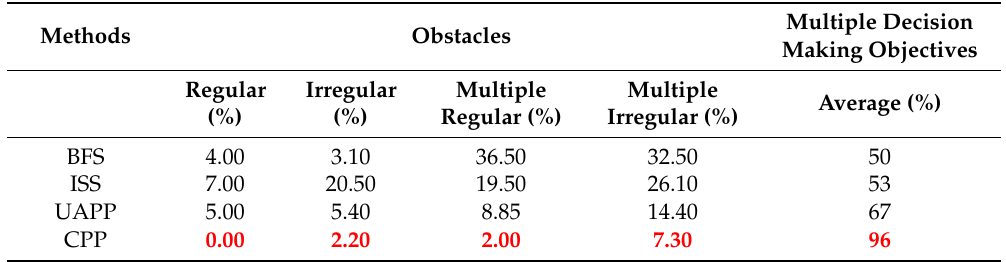
Table 6. An evaluation of the performance of alternative algorithms in differing